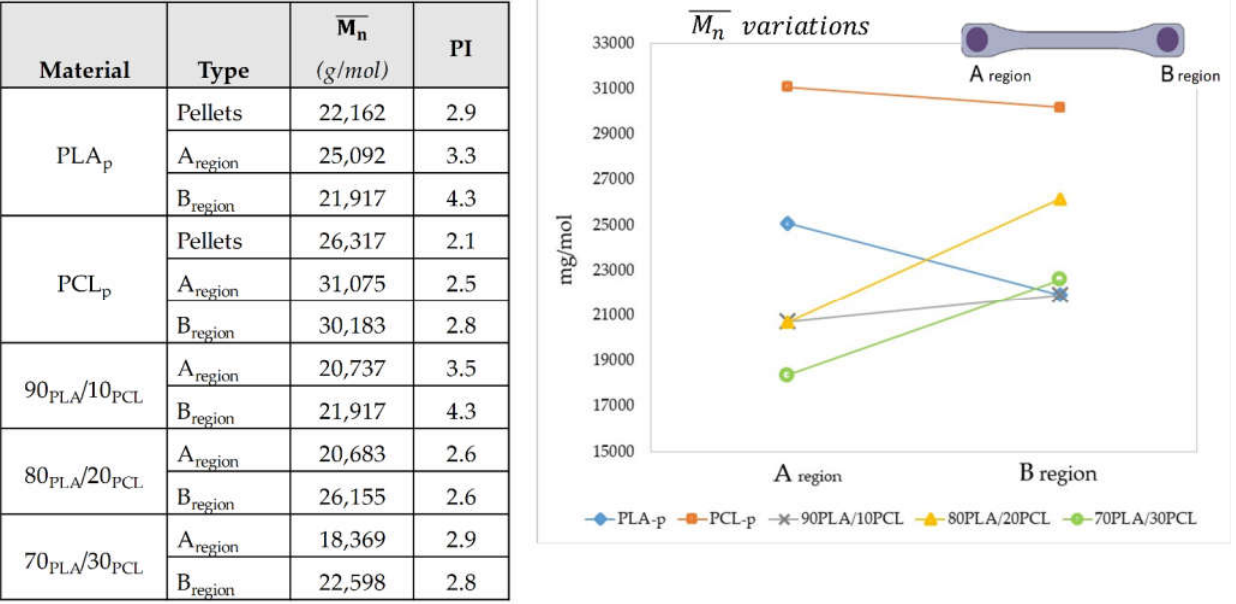
Figure 7.    and PI variations of the obtained pellets and specimens Figure 7. M n and PI variations of the obtained pellets and